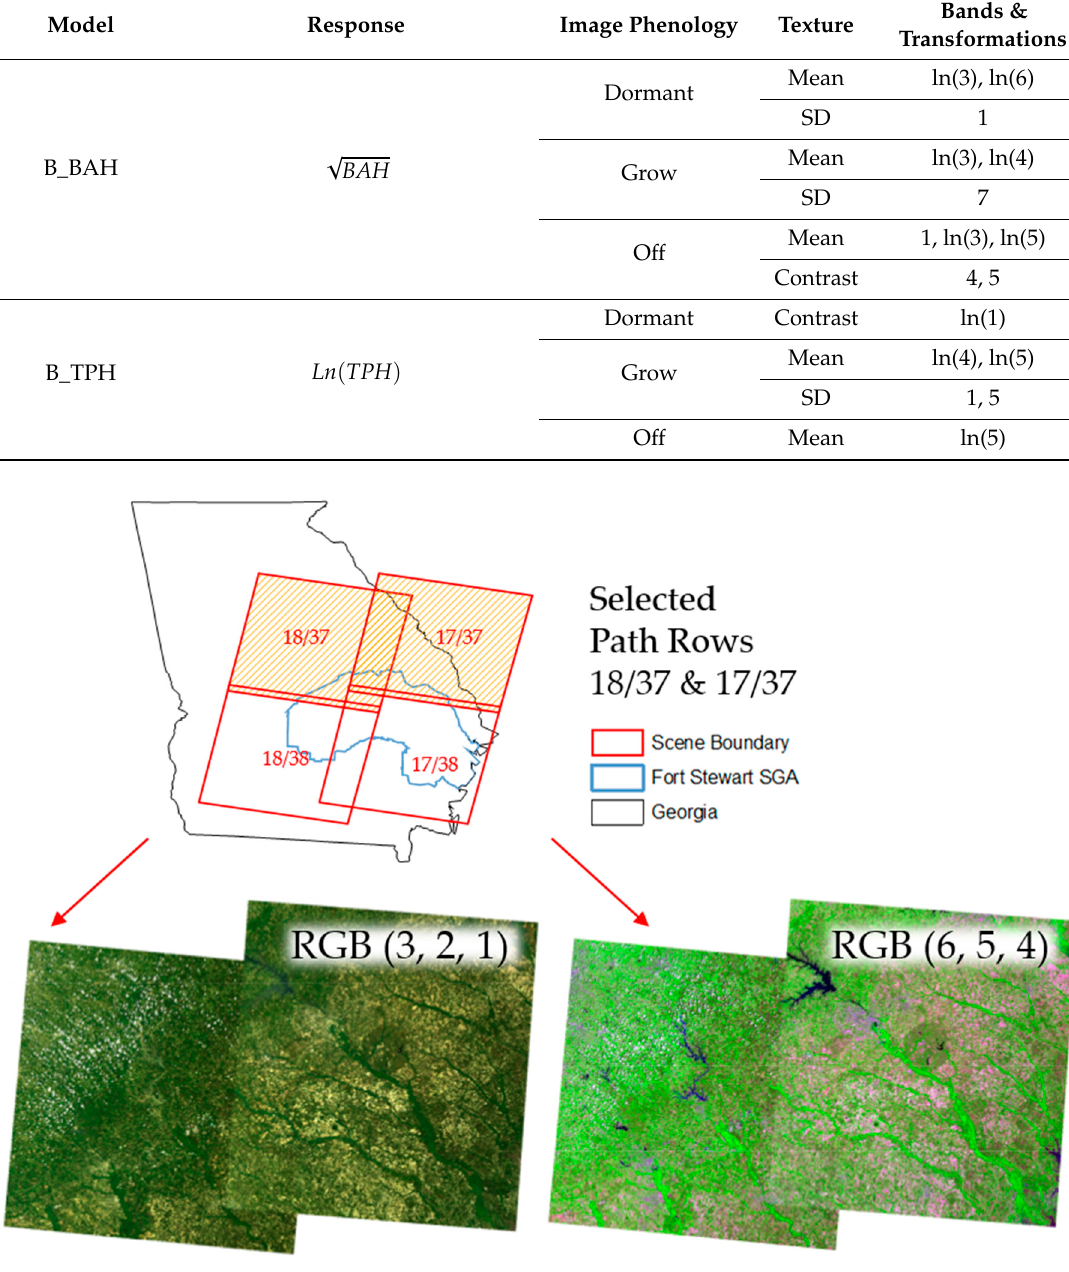
Figure A1. Example of visible scene boundary between two Landsat 8 images for the Growing phenology after converting DN values to surface reflectance [28]. Images have been mosaicked together with no blending of pixels values like in Figure 5 and are displayed in red, green and blue (RGB), color composites for specified band combinations.